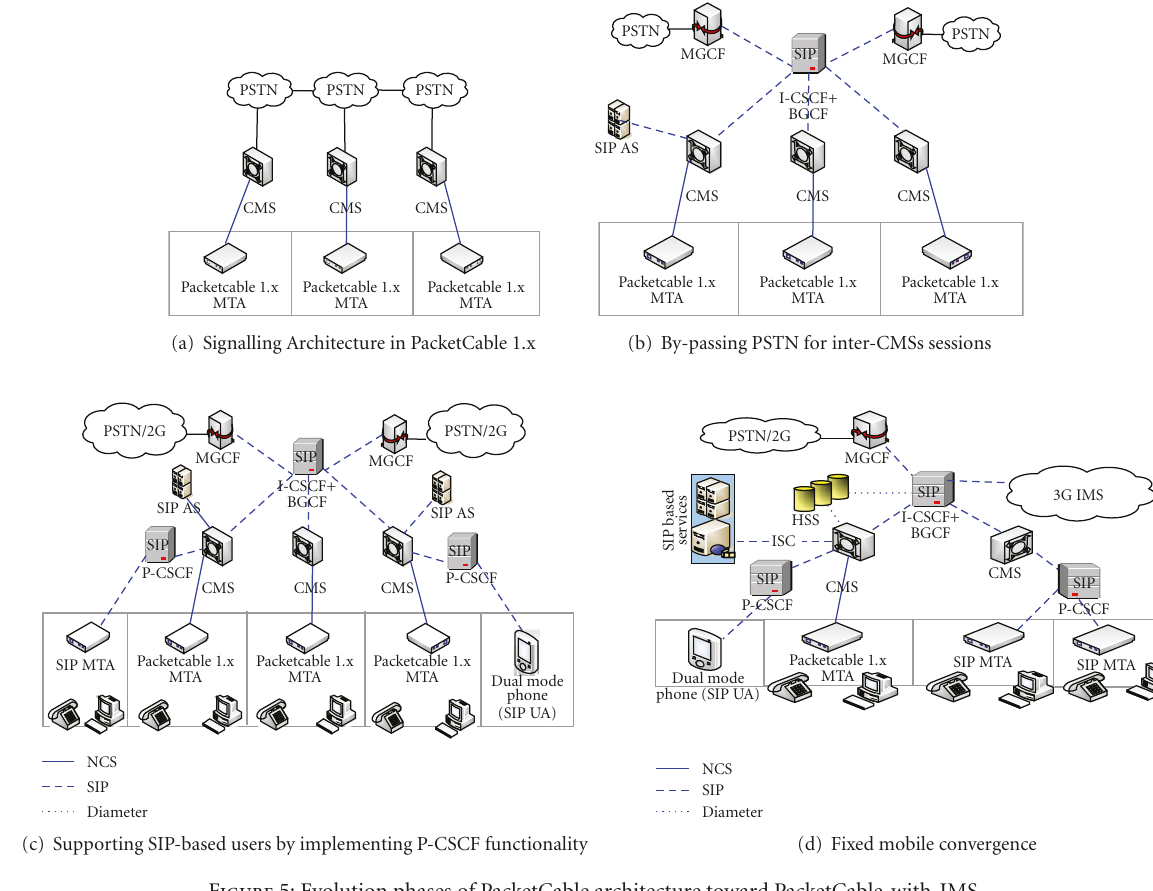
Figure 5: Evolution phases of PacketCable architecture toward